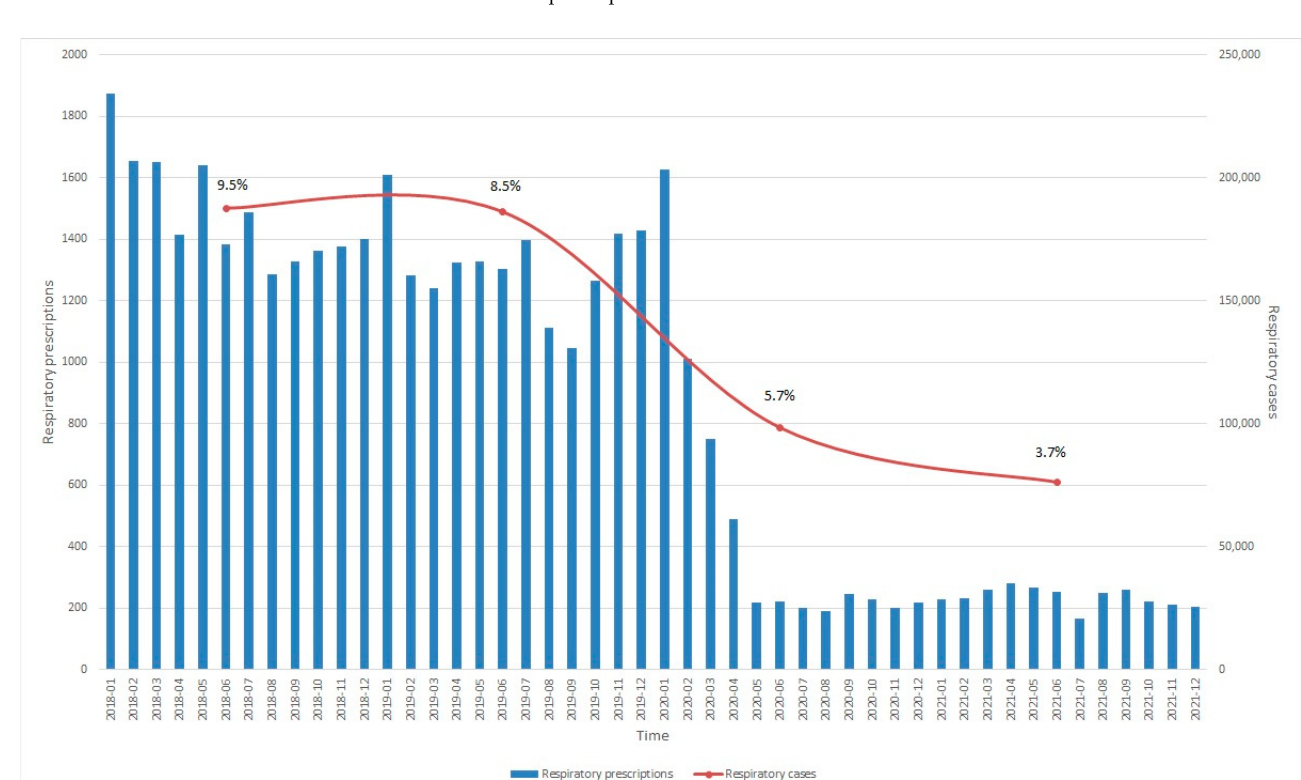
Figure 2. Respiratory visits and antibiotic prescriptions, 2018–2021. Prescriptions for dental, skin and soft tissue, and ear, nose, and throat (ENT) condi- tions remained stable from 2018 to 2021 (Table 2). While the absolute number of prescrip- tions for dental conditions remained low, it had the highest percentage of visits that were prescribed with antibiotics (17.8%). The number of visits with multiple infectious condi- tions reduced from 3.69% in 2018 to 1.67% in 2021. The number of antibiotics prescribed for unde fi ned conditions (diagnoses listed that were non-infectious in nature, such as chronic diseases) rose from 10.8% to 17.2% in terms of the total antibiotics prescribed across 2018 to 2021. While the patient(cid:31)s age (OR 1.005, 95% CI 1.004–1.006) was associated with antibiotic prescription for unde fi ned conditions, the physician(cid:31)s years of practice (OR 0.993, 95% CI 0.991–0.995) was found to have an inverse relationship (Table A2). On a multivariate analysis after adjusting for the patient(cid:31)s age and physician(cid:31)s years of practice, the female gender (OR 1.12, 95% CI 1.08–1.15), race ( p < 0.001), presence of diabetes melli- tus (OR 1.34, 95% CI 1.29–1.40) and chronic kidney disease (OR 1.31, 95% CI 1.26–1.37), place of practice ( p < 0.001), and having an accredited family physician (OR 1.16, 95% CI 1.12–1.20) were signi fi cantly associated with antibiotic prescriptions for unde fi ned condi- tions (Table A2). Figure 3 describes all the available oral antibiotics split into diagnoses and grouped according to the WHO AWaRE classi fi cation. The most common oral antibiotic prescribed from 2018 to 2021 was amoxicillin/clavulanate (58.8%). Skin and soft tissue infections had the highest percentage of antibiotic use in the Access group (98%). The overall increase in the use of antibiotics in the Access group from 85.6% (2018) to 92.1% (2021) was due to the reduction in clarithromycin use, particularly for respiratory conditions. Cipro fl oxacin constituted the largest proportion (68%) among the antibiotics used by the Watch group in 2021, of which the majority (70.6%) were prescribed for genitourinary conditions. Cipro fl oxacin was 7 and 16 times more likely to be prescribed for genitourinary (OR 7.41, 95% CI 7.05–7.78) and gastrointestinal (OR 16.1, 95% CI 14.9–17.4) conditions, respectively, compared to other conditions.